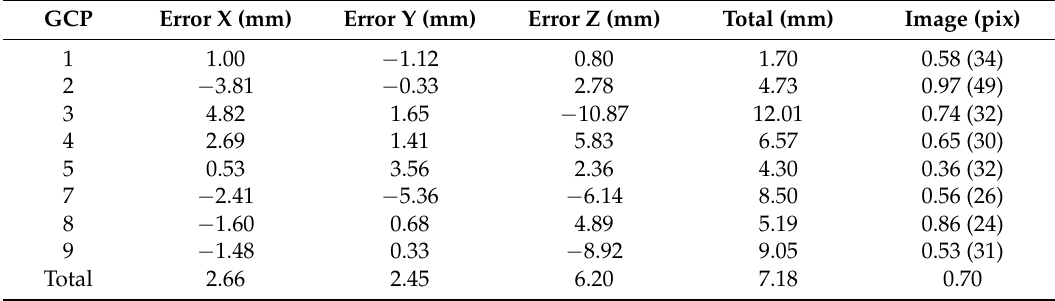
Table 4. Control points of images not filtered and not geometrically calibrated.